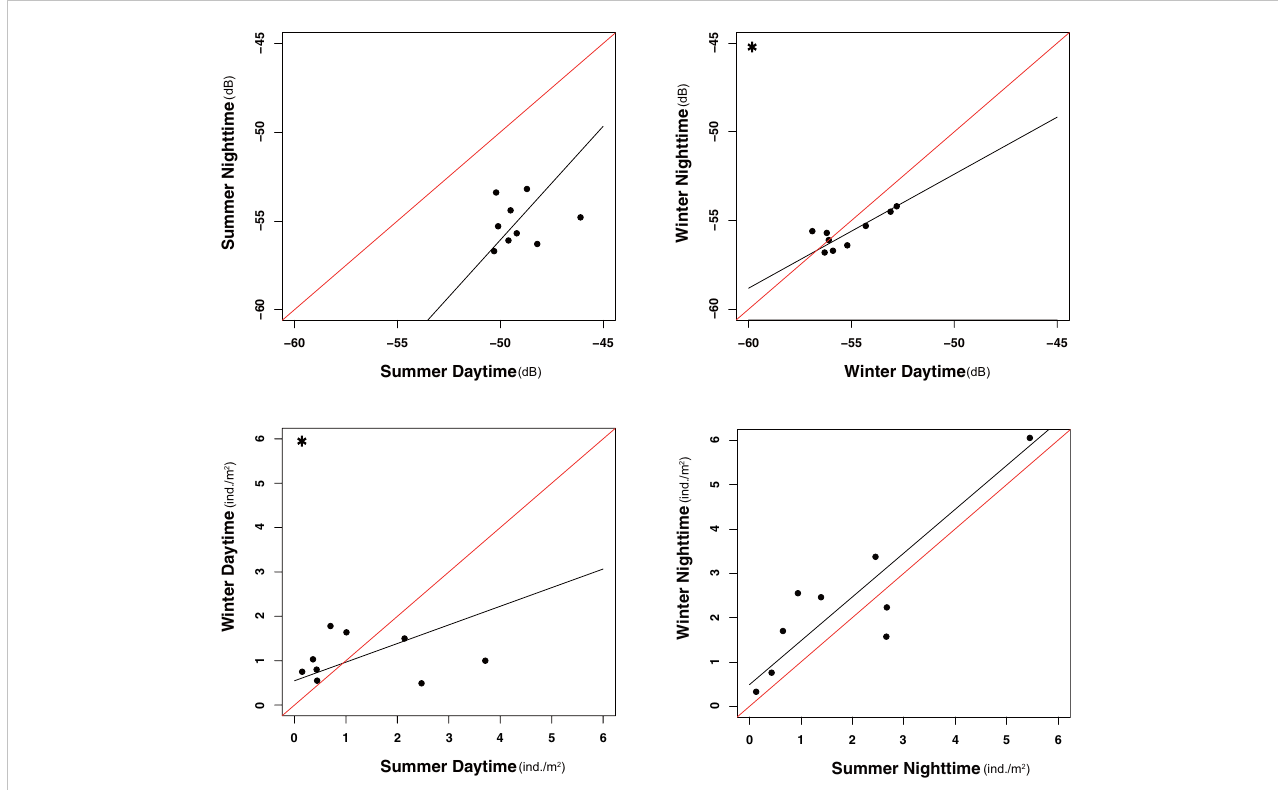
FIGURE 6 Linear relationship between diel and seasonal results for mean TS in nine areas. Asterisks in the upper left corner indicate signi fi cant correlations (p < 0.05). The red line represents the 1:1 line, and the black line the relationship estimated by the SMA (N =